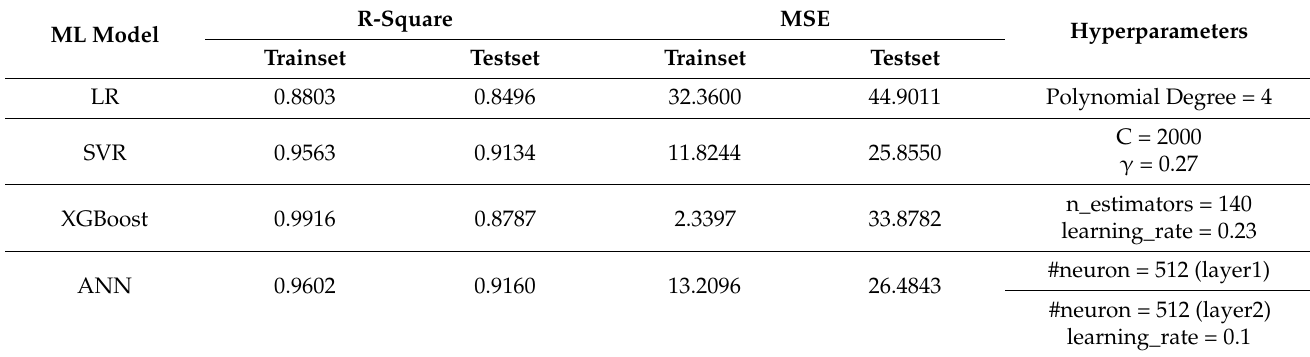
Table 5. Prediction results with 6 manually selected